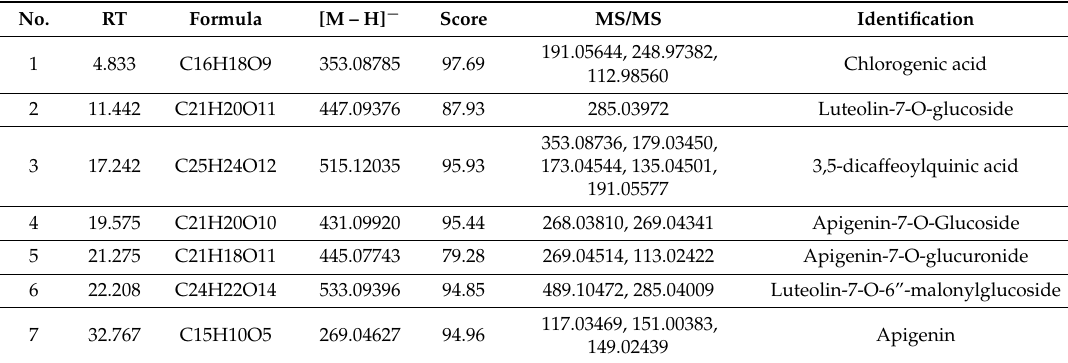
Table 1. Compounds identified from Chrysanthemum morifolium ‘Huangju’ by UHPLC-Q-TOF-MS.